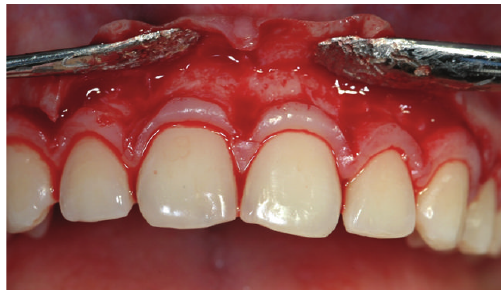
Figure 6: Bone level after flap